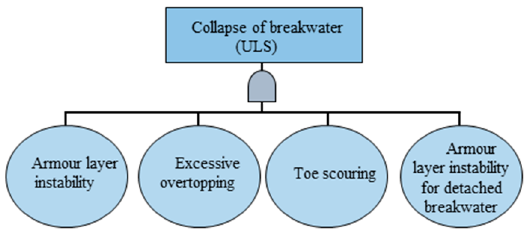
Figure 4. Fault tree for the ULS of a rubble mound breakwater with a detached structure.